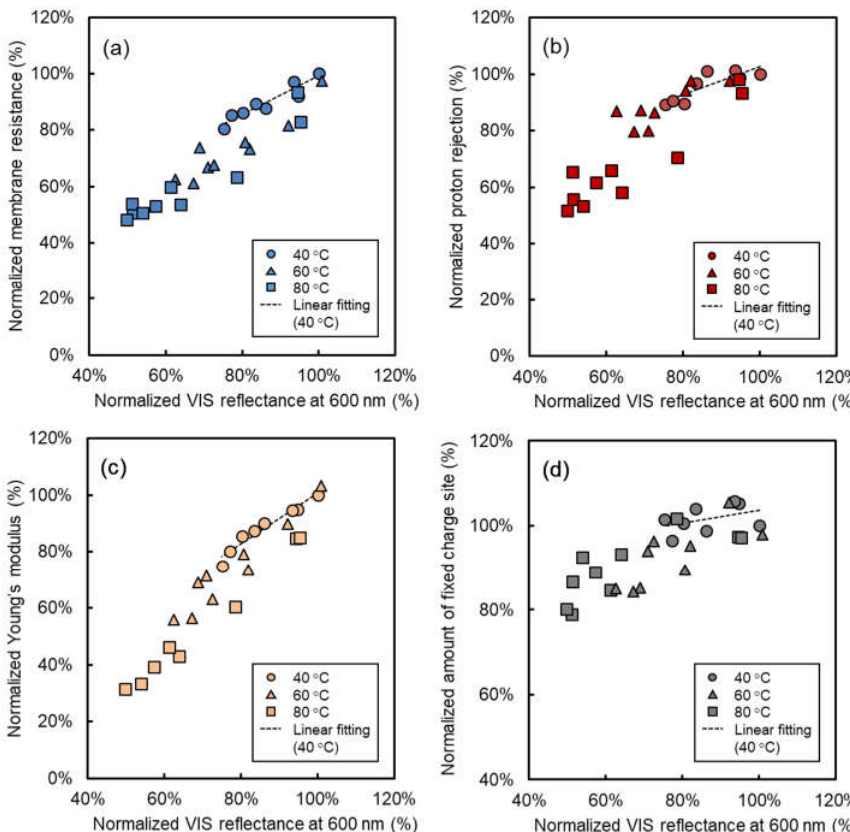
Figure A1. Correlation between normalized electrical and mechanical performance and normalized VIS reflectance at 600 nm after NaOH immersion at 40 °C, 60 °C, and 80 °C: normalized ( a ) electrical resistance, ( b ) proton rejection, ( c ) Young’s modulus, and ( d ) amount of fixed-charge sites.